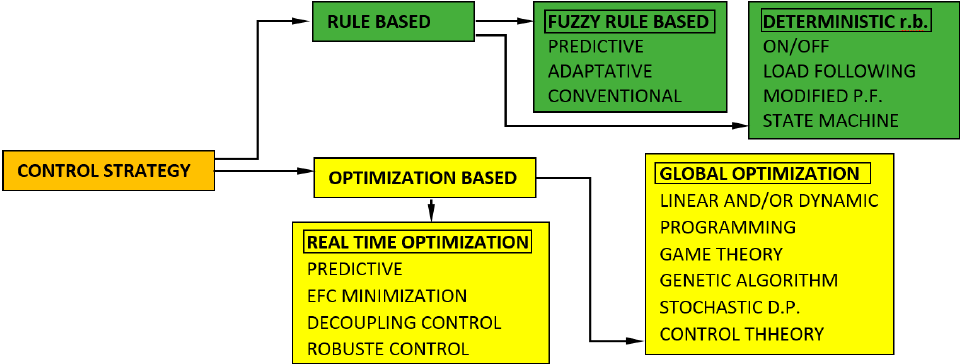
Figure 4. Control Strategies in HVs.